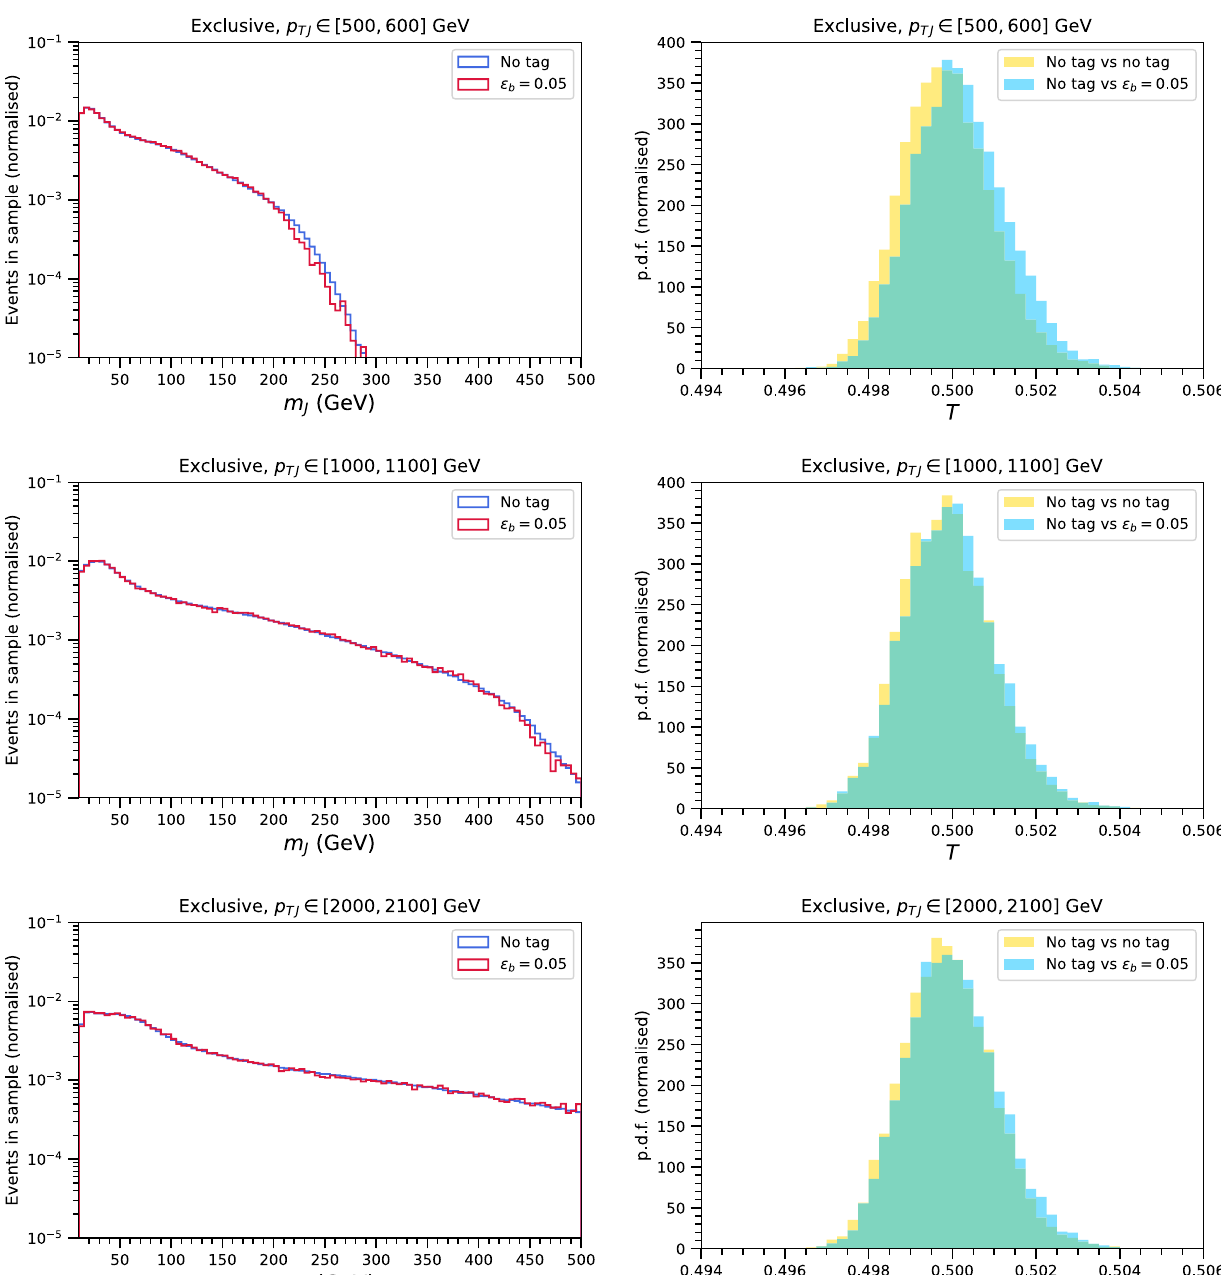
Fig. 6 Left: Jet mass distribution for QCD jets in three narrow p T samples, before tagging and after the application of the GenT 3 tagger and exclusive mass decorrelation with ε b = 0 . 05. Right: Probability